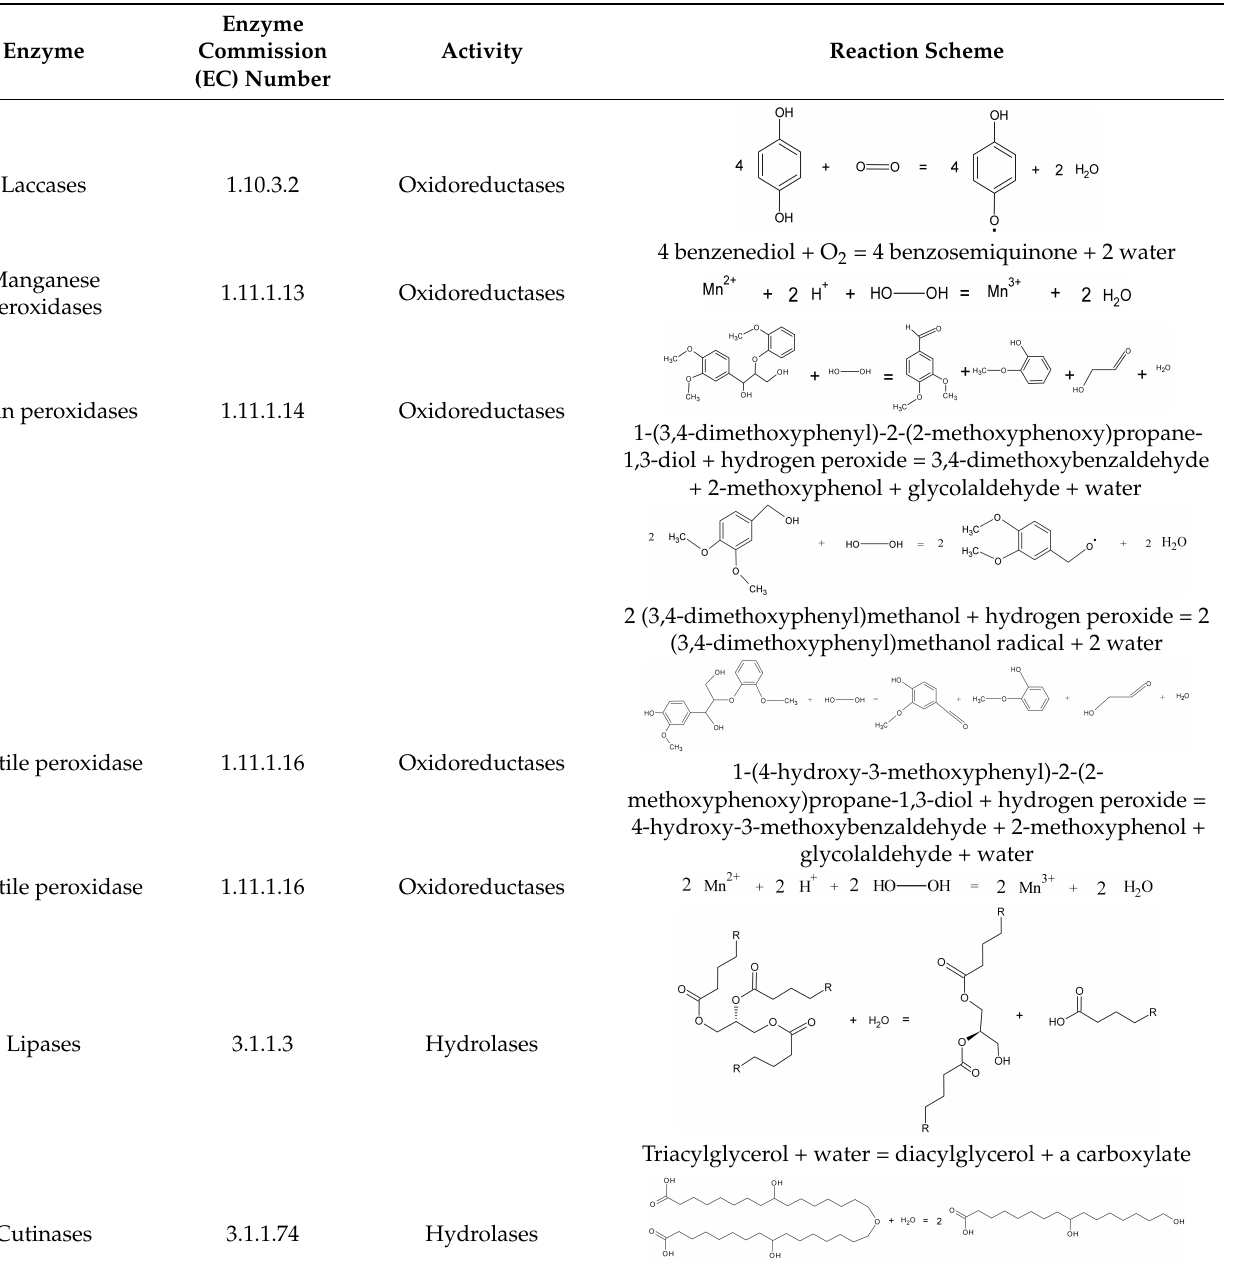
Table 1. Reaction schemes of the main fungal enzymes involved in plastic